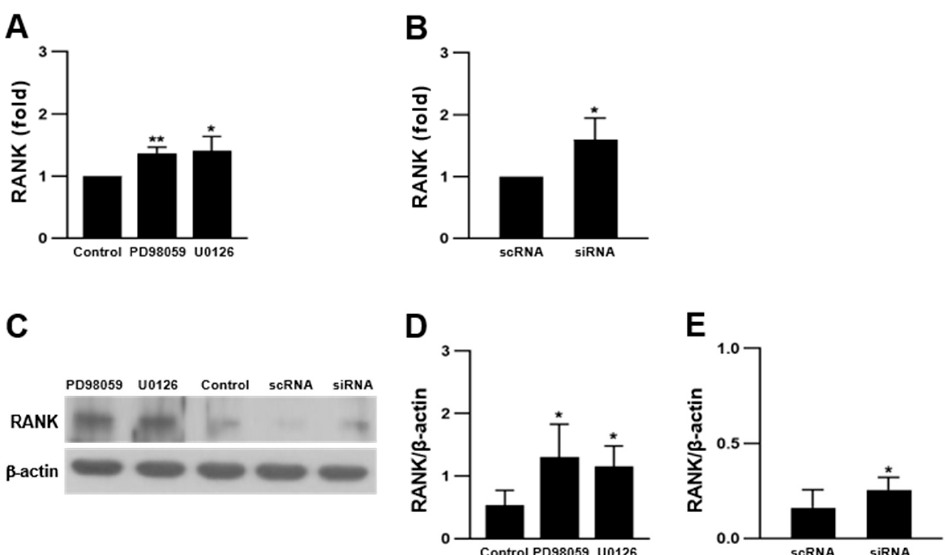
Figure 4. Inhibition of ERK increased expression of RANK. RAW 264.7 cells were treated with 5 µ M PD98059 and 2 µ M U0126, or were transfected with ERK2 siRNA, and differentiated into OCs in the presence of 50 ng/mL RANKL for 4 days. ( A , B ) Quantitative analyses of mRNA expression by ERK inhibitors and ERK2 siRNA (n = 3). ( C – E ) Protein expression of RANK in ERK inhibitor-treated and ERK2 siRNA-transfected cells (n = 3). Each result represents the mean ± SD. * p < 0.05 and ** p < 0.01 vs. control or scRNA.